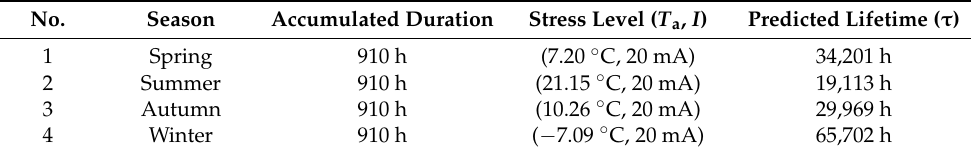
Table 3. Predicted lumen lifetimes under various emission profiles.